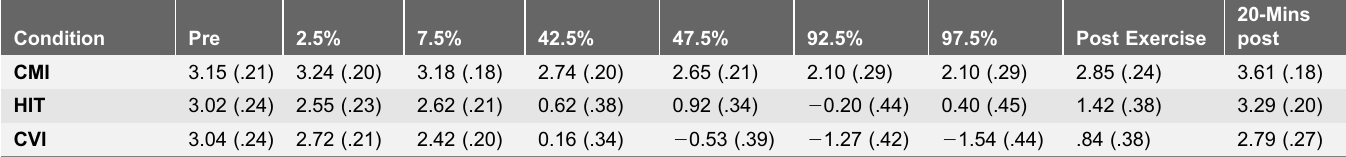
Table 2. Feeling Scales responses (mean ¡ SE) measured before, during and after the three exercise conditions. Condition